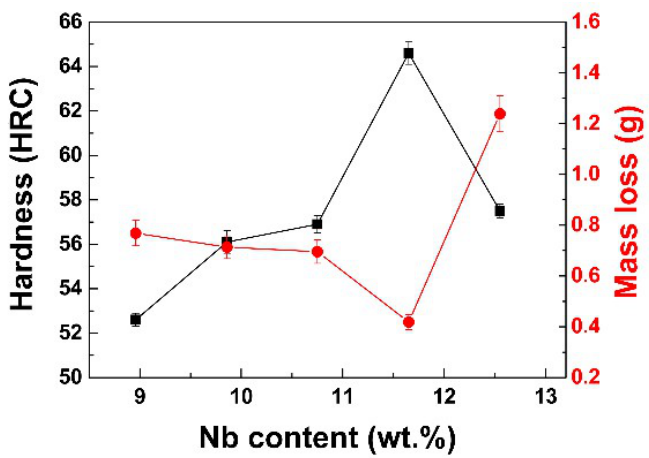
Figure 6. Rockwell hardness and mass loss (during wear testing) plotted as a function of the Nb contents of the coatings.